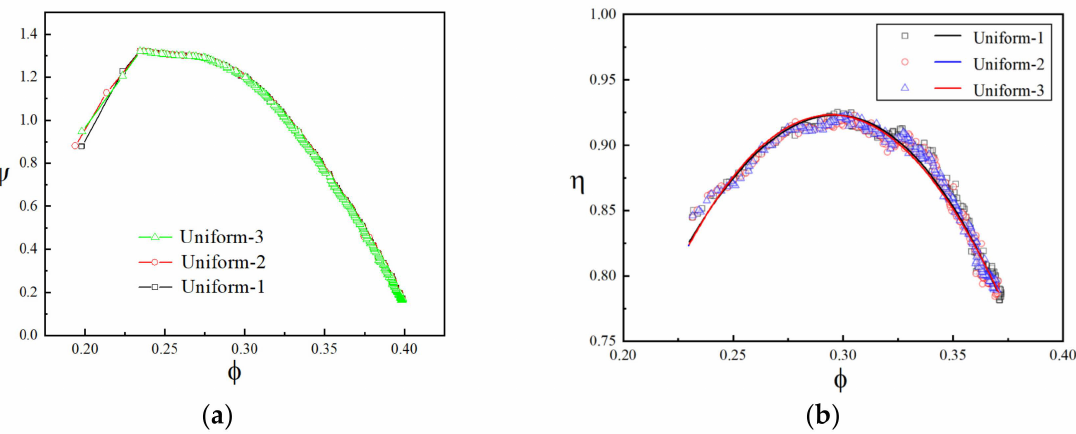
Figure 6. Repetitive experiment results of the ( a ) total-to-static pressure rise curves and ( b ) efficiency curves of the TA66 compressor.